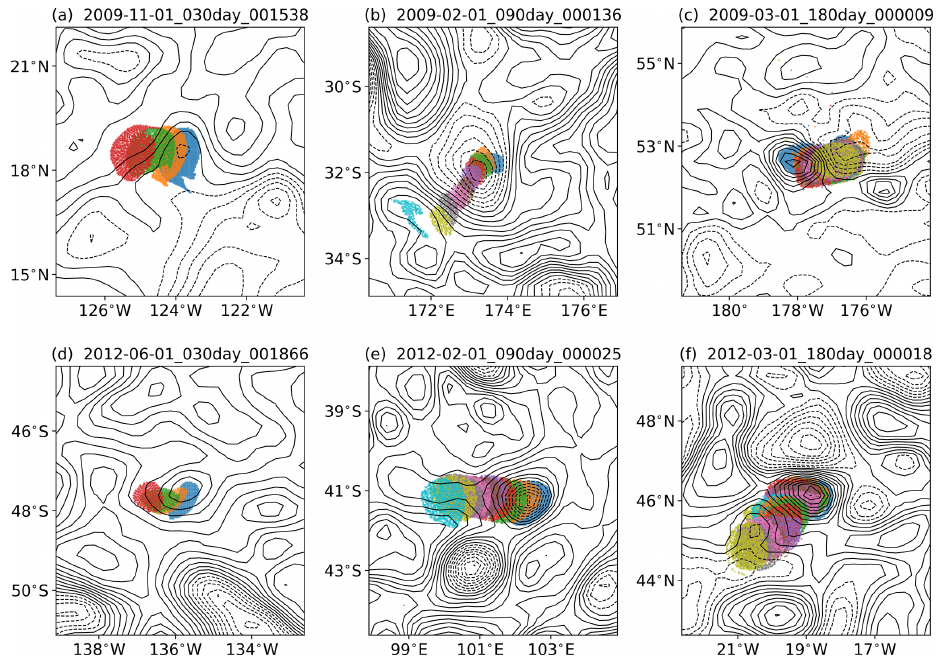
Figure 5. Positions of particles (colored dots) inside the eddy boundary every 10d for randomly selected (a,d) 30d, (b,e) 90d, and (c,f) 180d RCLVs. The unique eddy ID is marked in the title of each panel. Different colors denote the different times, and the blue dots represent the initial positions. The SLA fields are overlaid using black contours with solid lines for positive values and dashed lines for negative